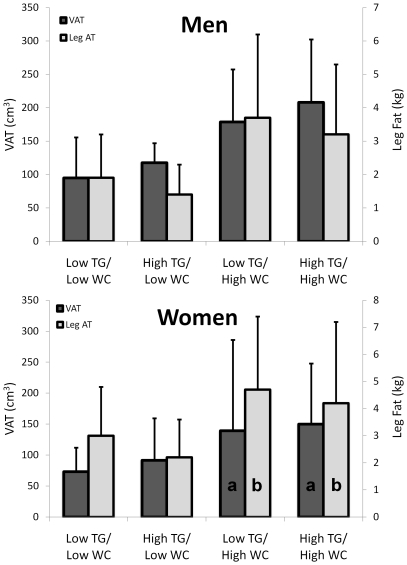
VAT and leg fat among HIV-infected men (top panel) and women (bottom panel) according to WC and TG category.Bars represent means, and the error bars represent the standard deviation. Bars with the same inset letter are not statistically different from one another (p>0.05). All other comparisons are significant (p<0.05).